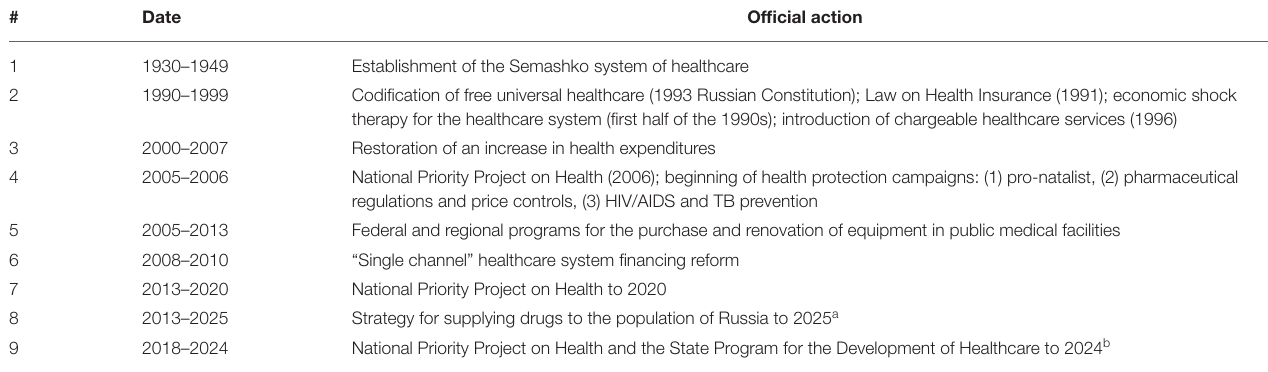
TABLE 1 | History of official actions in the Russian health